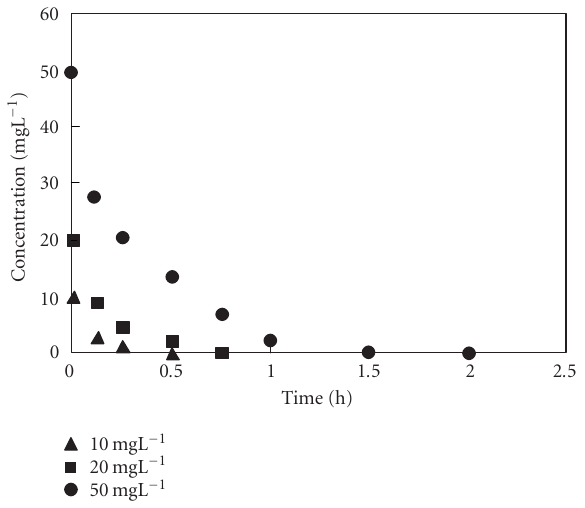
Figure 2: Photocatalytic degradation of aqueous solutions of lin- comycin.